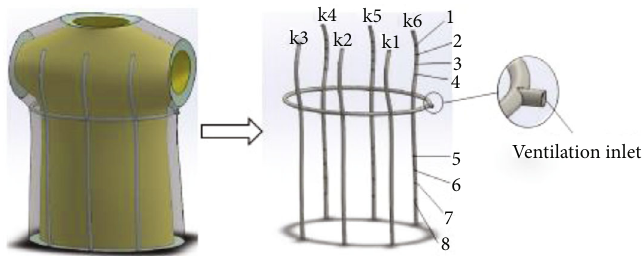
Figure 2: Transverse type.